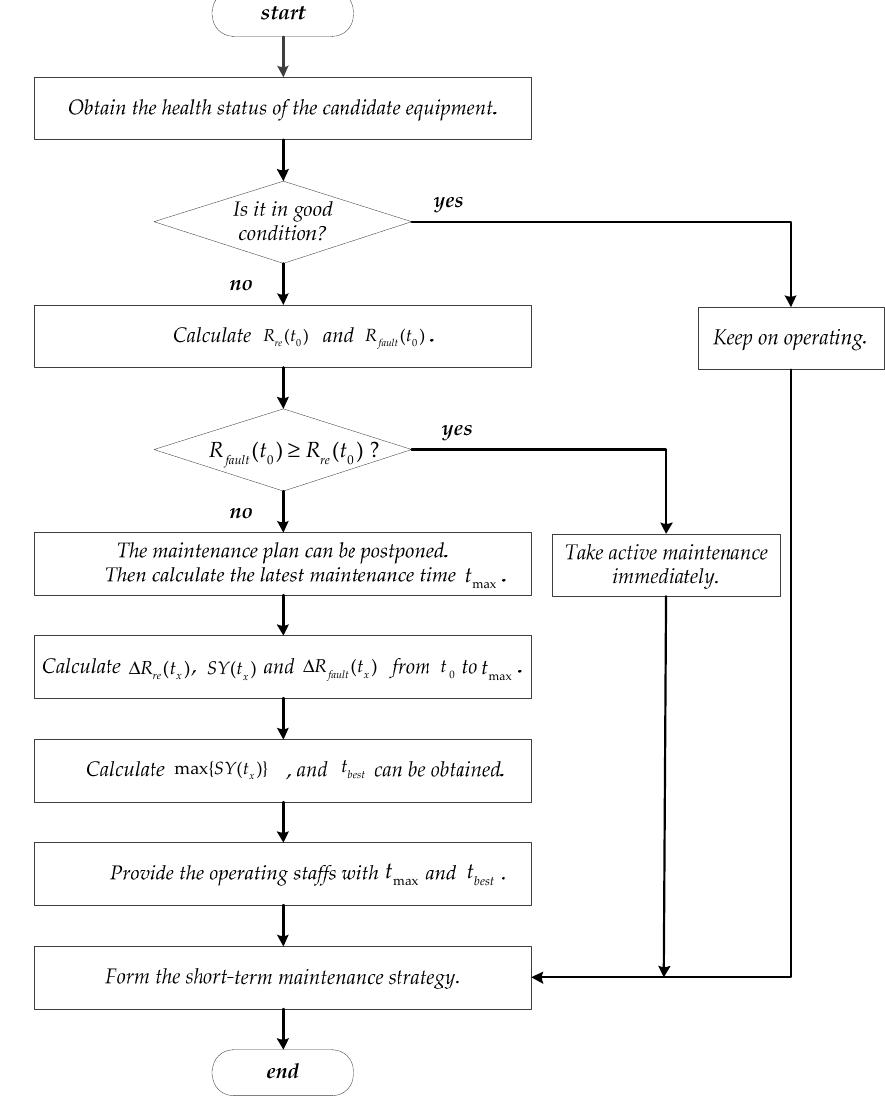
Figure 2. The flow diagram of the short-term maintenance strategy based on risk-cost-analysis.